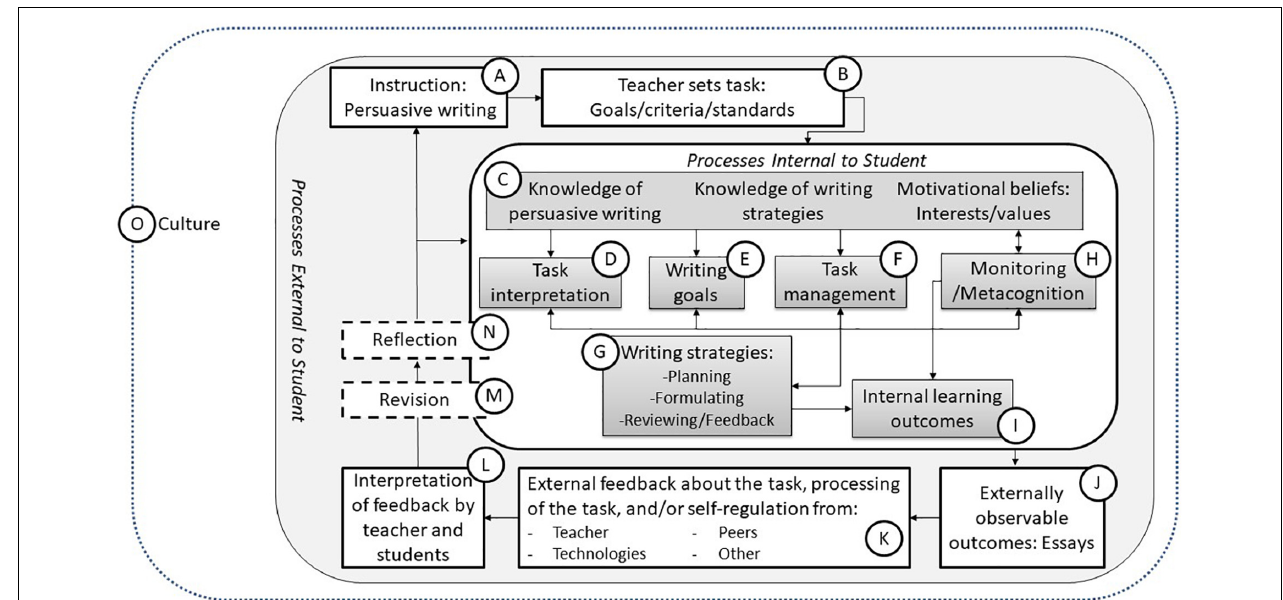
FIGURE 1 | Model of self- and socially-regulated multilingual